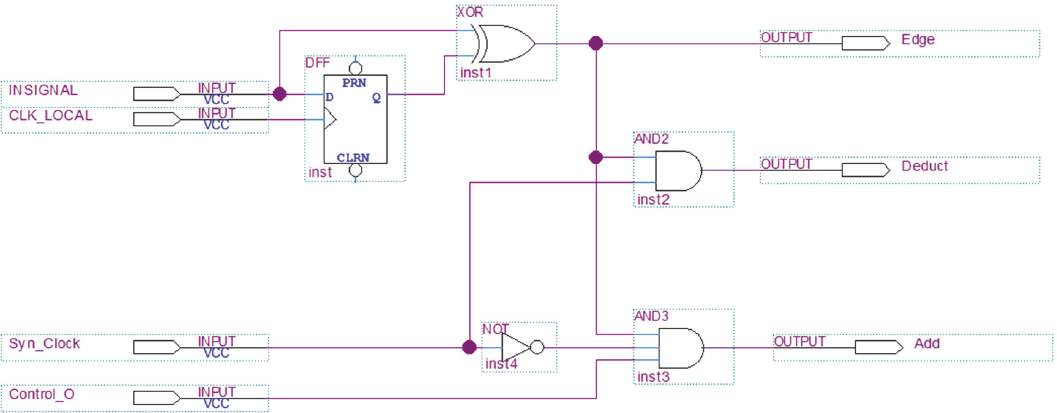
Figure 3: Schematic of differential phase detector.